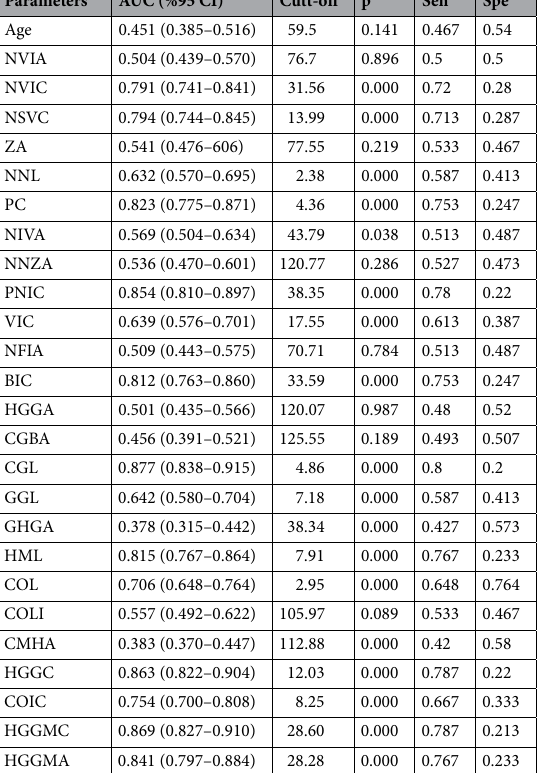
Table 3. ROC result